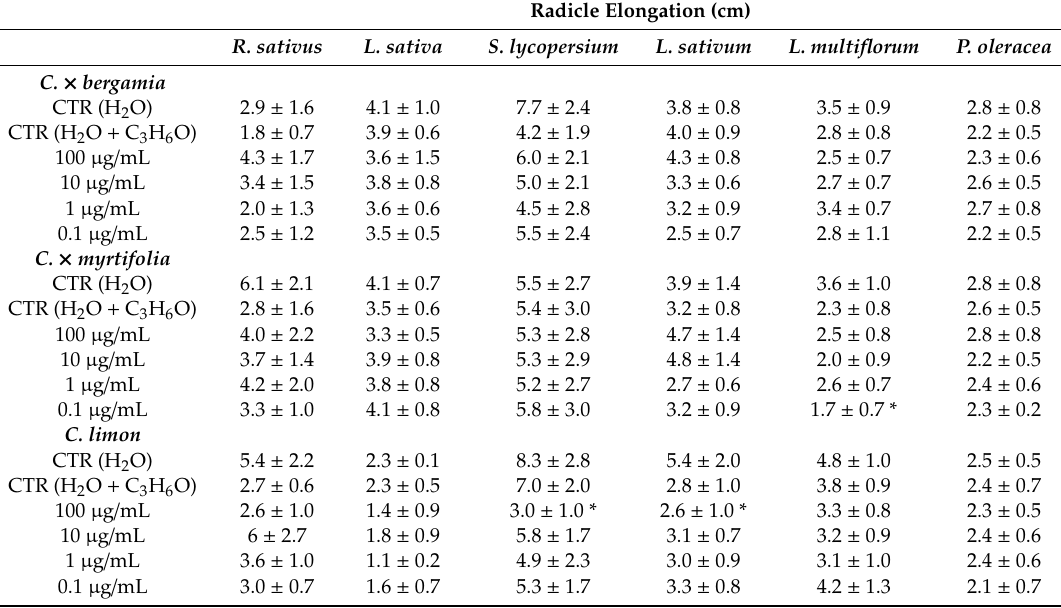
Figure 6. Phytotoxic activity of the EOs of C. limon against radical elongation of S. lycopersium ( A ), L. sativum ( B ) and germination of R. sativus ( C ), 120 h after sowing. Results are the mean of three experiments ± standard deviation. * p < 0.05 compared with control (ANOVA followed by Dunnett’s multiple comparison test). Finally, none of the EOs was active against germination or radicle elongation of L. sativa seeds (Tables 3 and 4).